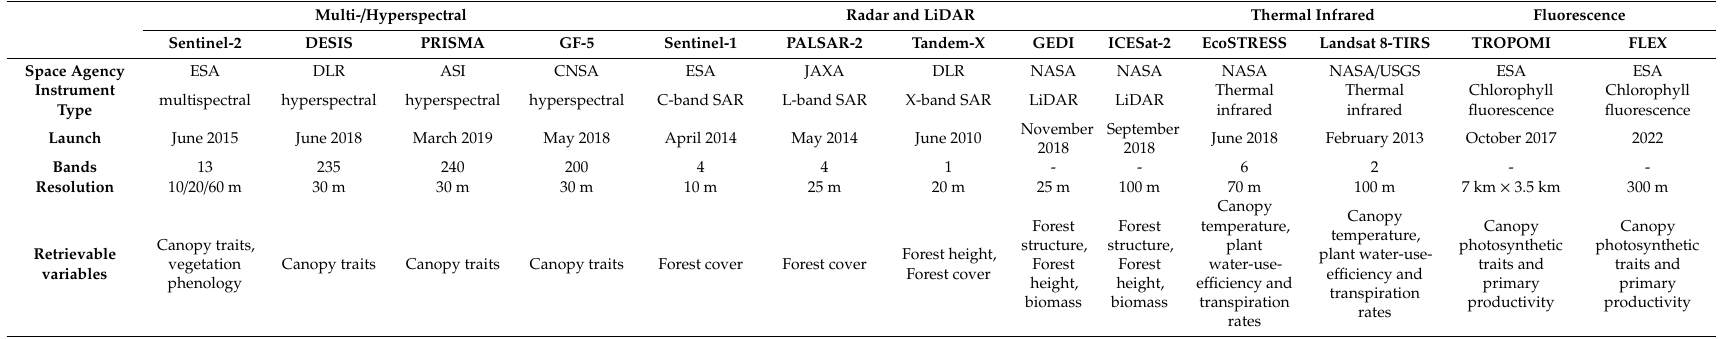
Table 1. List of some new generation spaceborne Earth observation (EO) missions that can be used to infer plant traits and functional